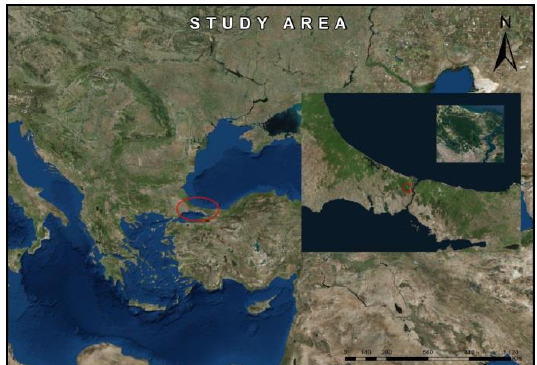
Fig. 1. Location of test site in